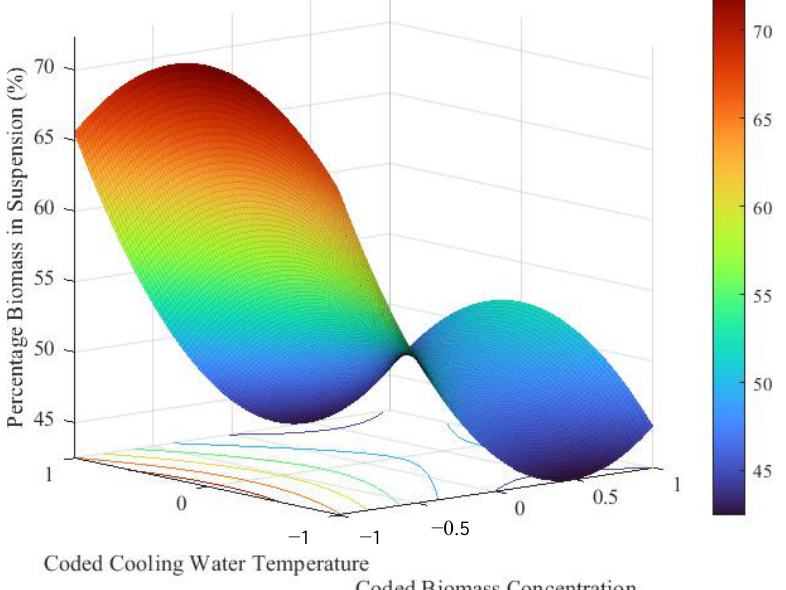
Figure 5. Response surface plot for the percentage biomass in suspension (model plotted at the mid-